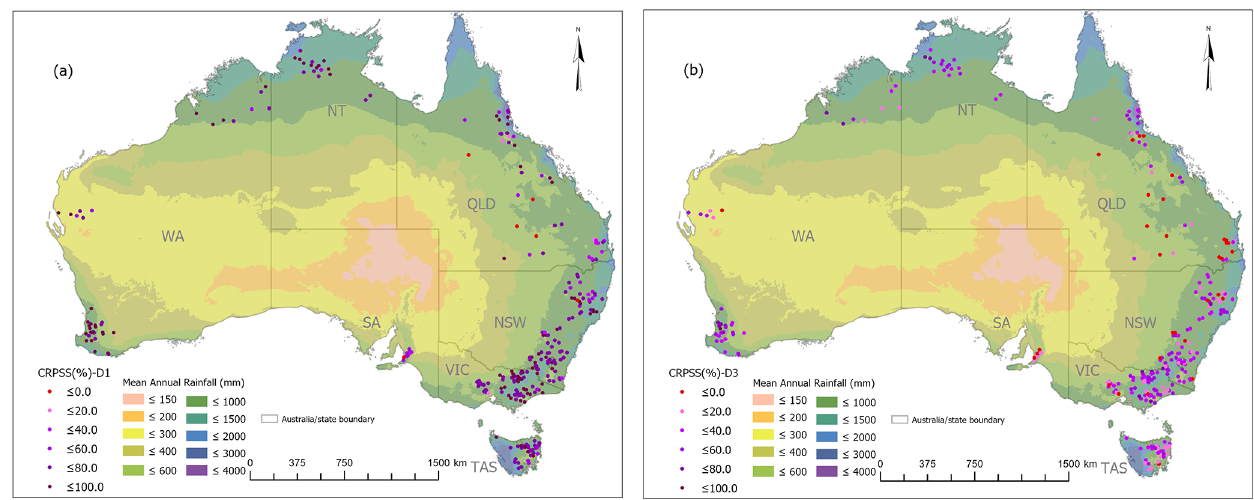
Figure 13. Forecast skill, CRPSS (%) for the 283 forecast locations (a) for lead-days 1 and (b) for lead-days 3. The mean annual rainfall (mm) in Australia is shown in the